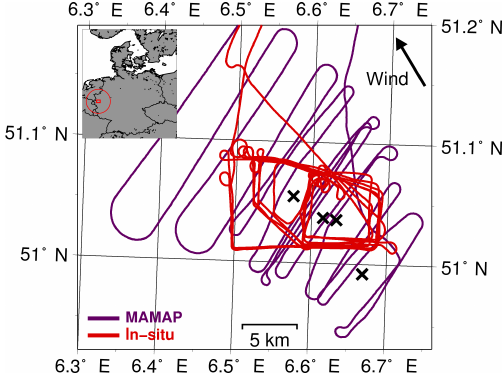
Figure 1. Map of the target area in western Germany. The crosses denote the four lignite-fired power plants in the area. From upwind to downwind, i.e. from south-east to north-west, the power plants are Niederaußem, Neurath (new), Neurath (old) and Frimmersdorf.